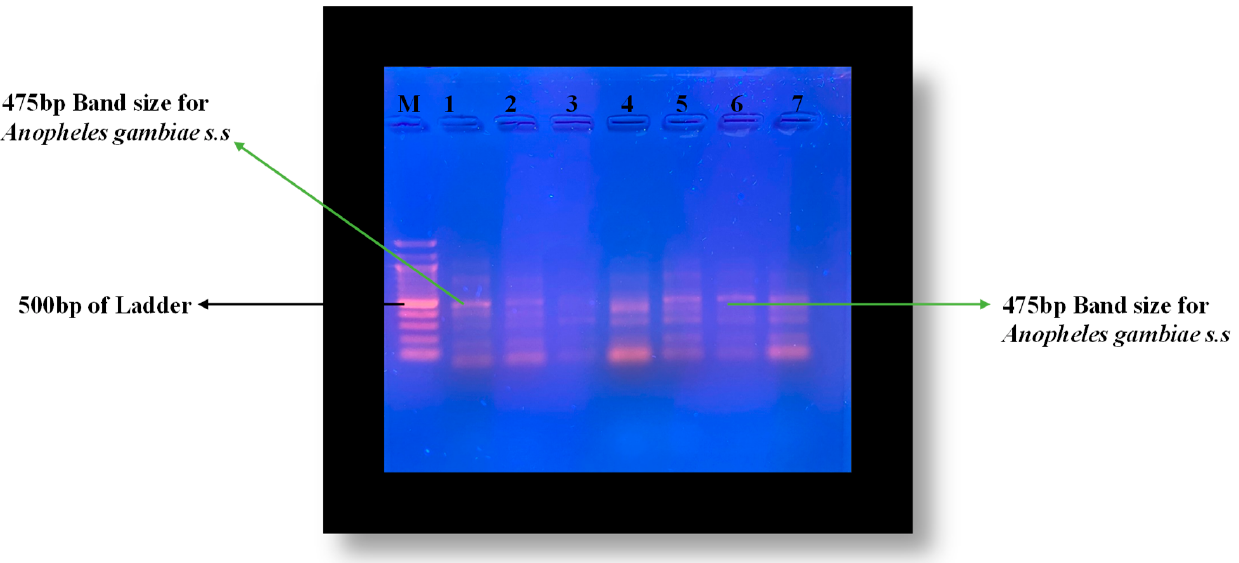
Figure 6. Agarose gel 1.5% for distinguishing A. gambiae s.s and coluzzi after PCR with primers (R3, R5, B/Sint and MoPint).